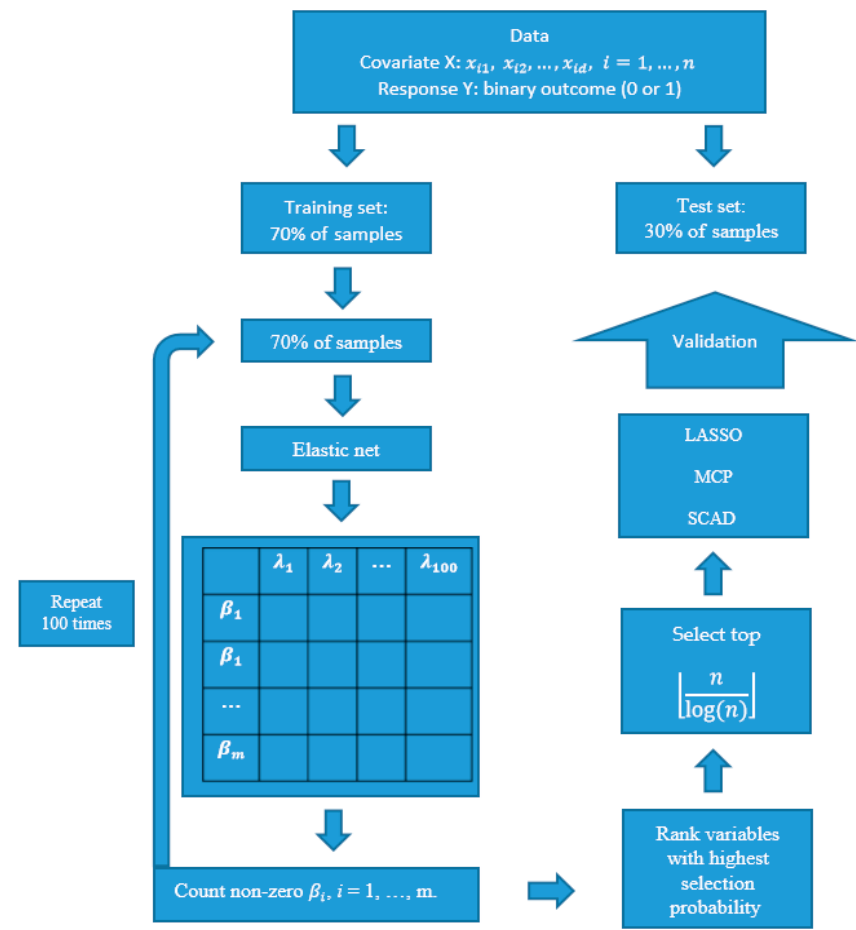
Figure 1. Diagram showing the proposed two-step procedure.